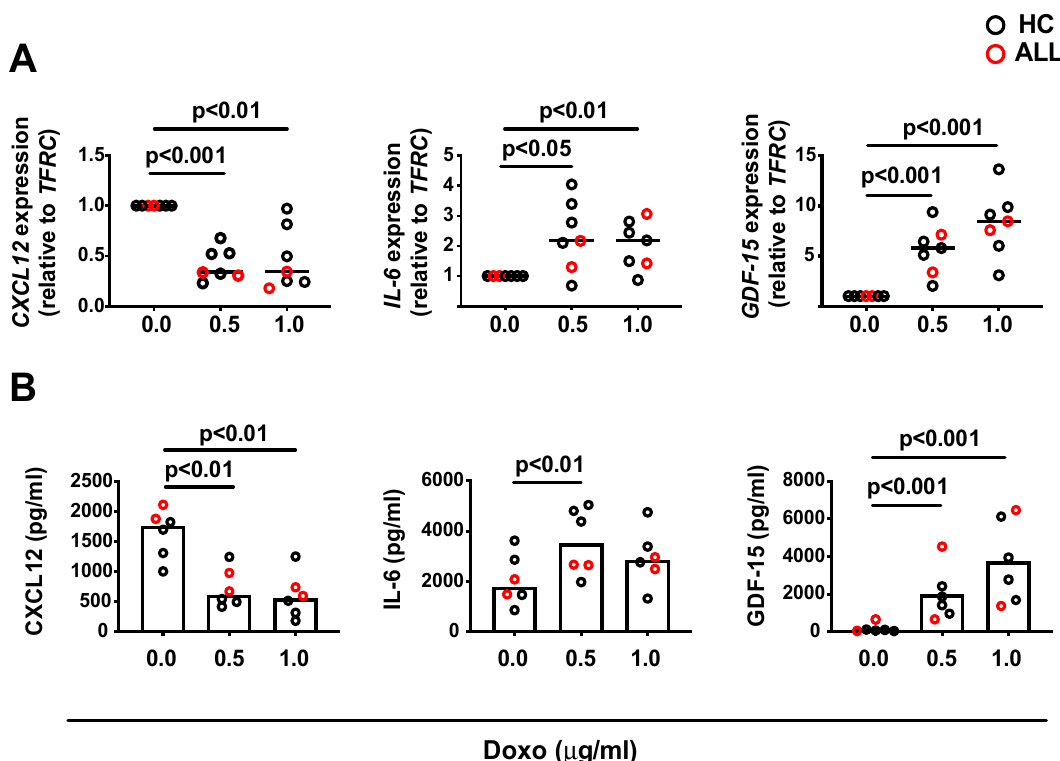
Figure 2. Alterations in CXCL12, interleukin 6 IL-6 and growth and differentiation factor 15 (GDF-15) gene and protein expression by BM MSC following in vitro exposure to doxorubicin. ( A ) Relative CXCL12 , IL-6 and GDF-15 , mRNA levels normalized to TFRC , quantified by real time PCR in BM MSCs following Doxo exposure ( n = 7 donors). ( B ) CXCL12, IL-6 and GDF-15 protein levels in the BM MSC supernatants after Doxo exposure, measured by ELISA ( n = 6 donors). ( A , B ) Data acquired during two independent experiments. O : Healthy controls, O : Children under treatment for ALL